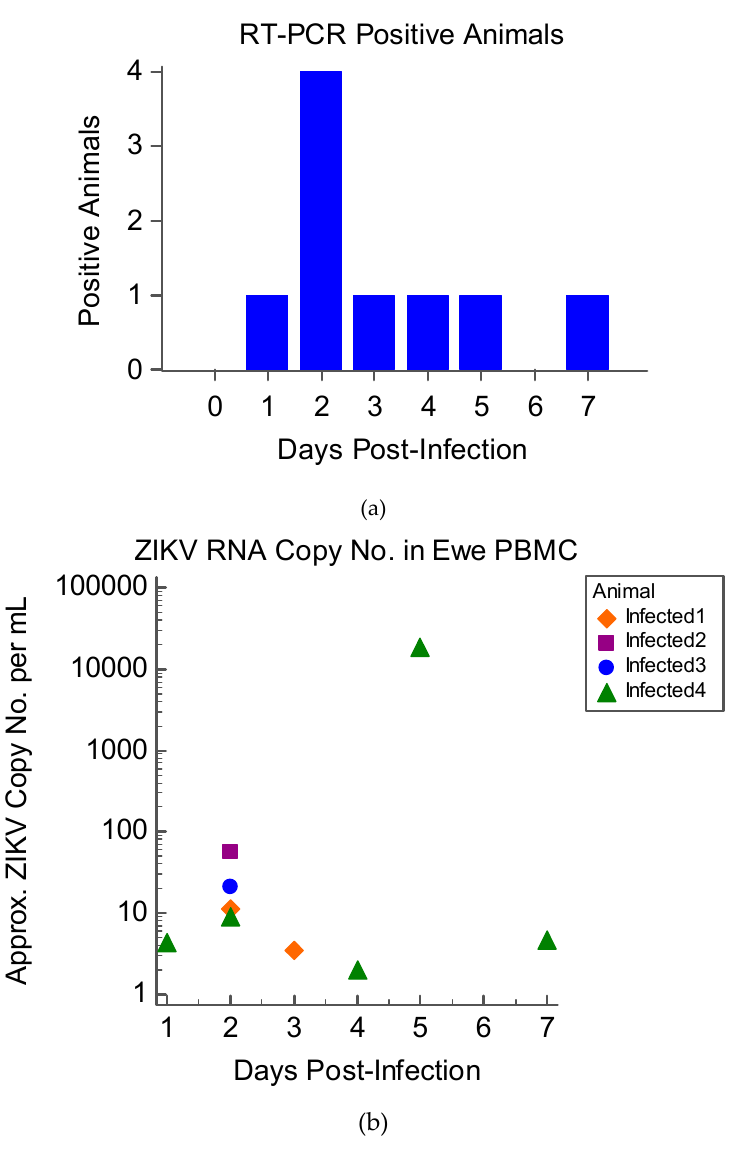
Figure 3. Real-time PCR results of four ewes infected with 1 × 10 6 PFU Zika virus (ZIKV) at 36–42 days gestation: (a) The number of infected animals with PCR-positive peripheral blood mononuclear cells (PBMC) by DPI; (b) Scatterplot of the approximate copy number of genomic ZIKV RNA per mL of sample calculated for each individual infected animal by day post-infection.